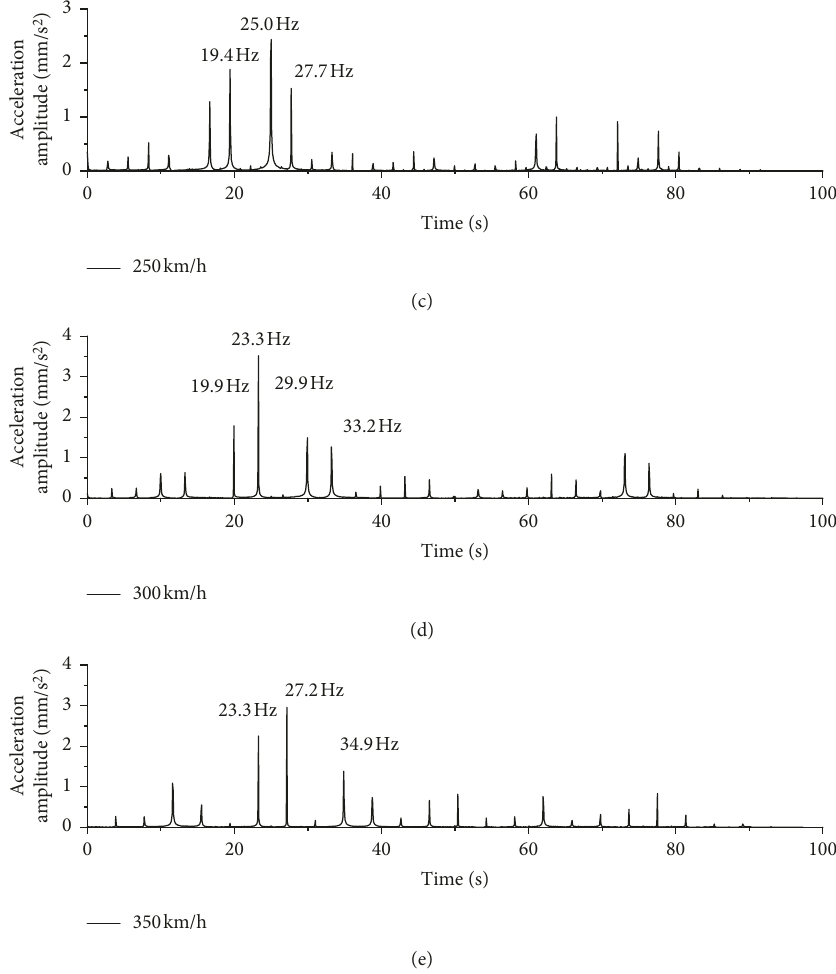
Figure 15: Spectrum curve of acceleration under different